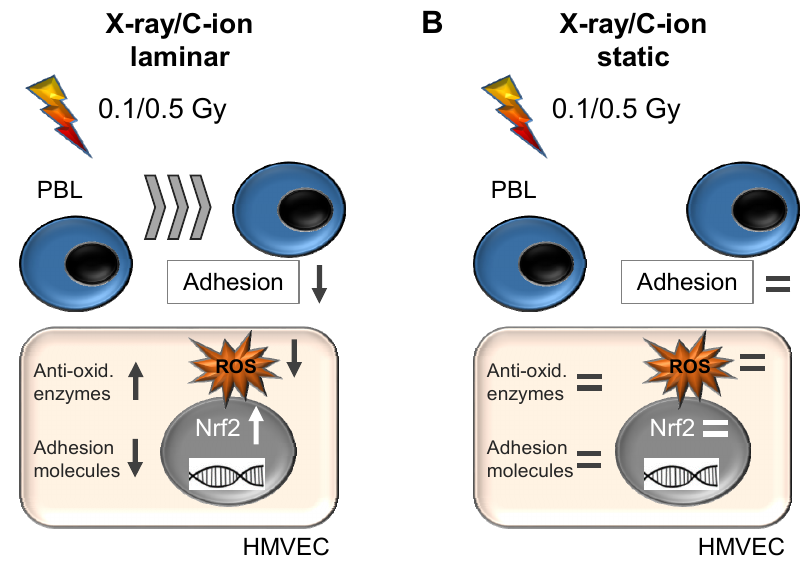
Figure 7. Irradiation of primary endothelial cells (HMVEC) with X-ray and C-ions induces shear stress-dependently the expression of anti-oxidative factors, reduces ROS and decreases PBL adhesion at doses between 0.1 and 0.5 Gy only under physiological shear stress. ( A ) X-ray or carbon ion (C-ion) irradiation with low doses induces under laminar conditions the expression of the transcription factor Nrf2, expression of anti-oxidative enzymes (Anti-ox. enzymes), decreases adhesion molecule expression and PBL adhesion, thereby probably contributing to anti-inflammatory effects of low-dose radiation therapy. ( B ) In contrast, low-dose irradiation of HMVEC cells under normal, static cell culture conditions does not modulate the anti ‐ oxidative system or leukocyte adhesion.